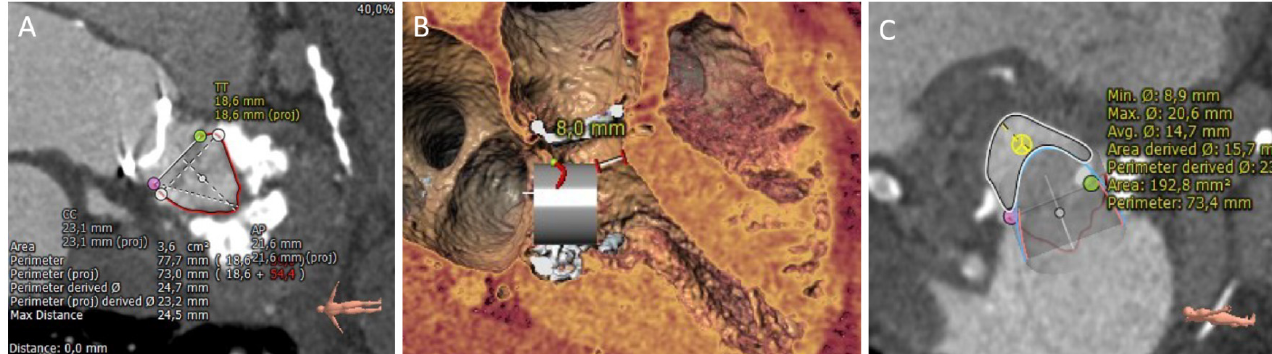
Figure 1. TMVR valve-in-MAC pre-procedural planning. ( A ) Mitral annular calcification with a 180° extension in the posterior and lateral aspect of mitral annulus. Internal dimensions can be noted on the image (TT: inter-trigone diameter; AP: anterior-posterior diameter; area and perimeter). ( B ) Three-dimensional virtual valve implantation (SAPIEN 3 23 mm) with a distance neo-valve to interventricular septum of 8 mm. ( C ) Neo-LVOT area according to the virtual valve implantation (Area 193 mm 2 ).